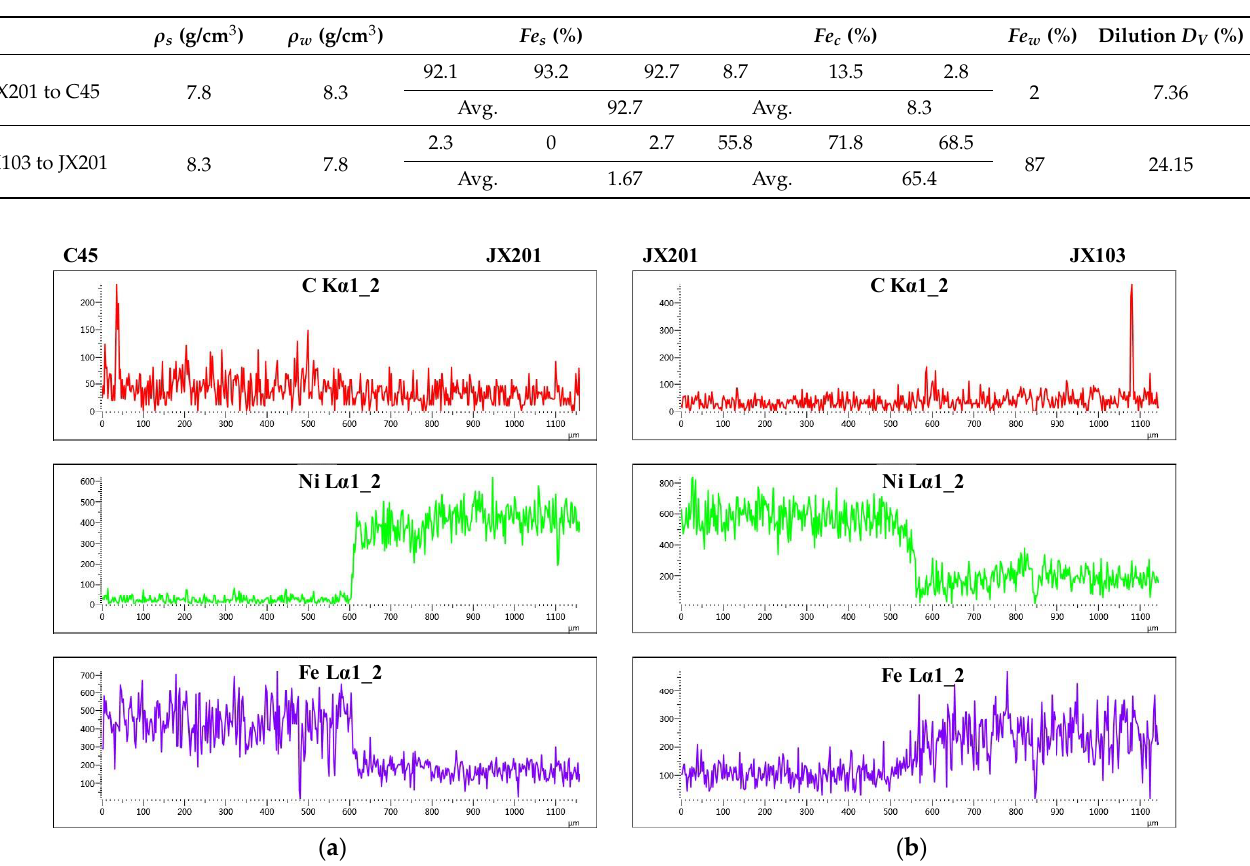
Figure 8. Element distributions of the two fusion boundaries: ( a ) Fusion boundary of JX201 and C45; ( b ) Fusion boundary of JX103 and JX201. ( b ) Fusion boundary of JX103 and Table 2. Dilution calculation of the two boundaries .